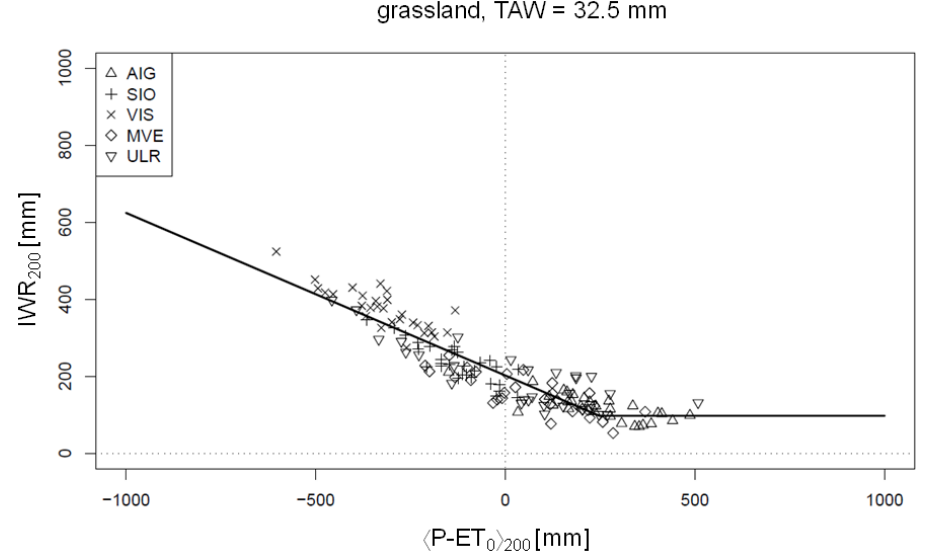
Figure 2. Relationship between seasonal IWR 29 years of simulated data for cut grassland with TAW = 32.5 mm at the sites given in Table 1 and shown in Figure 1. The line represents Equation (11), with the horizontal branch to the right indicating IWR combinations of crops and